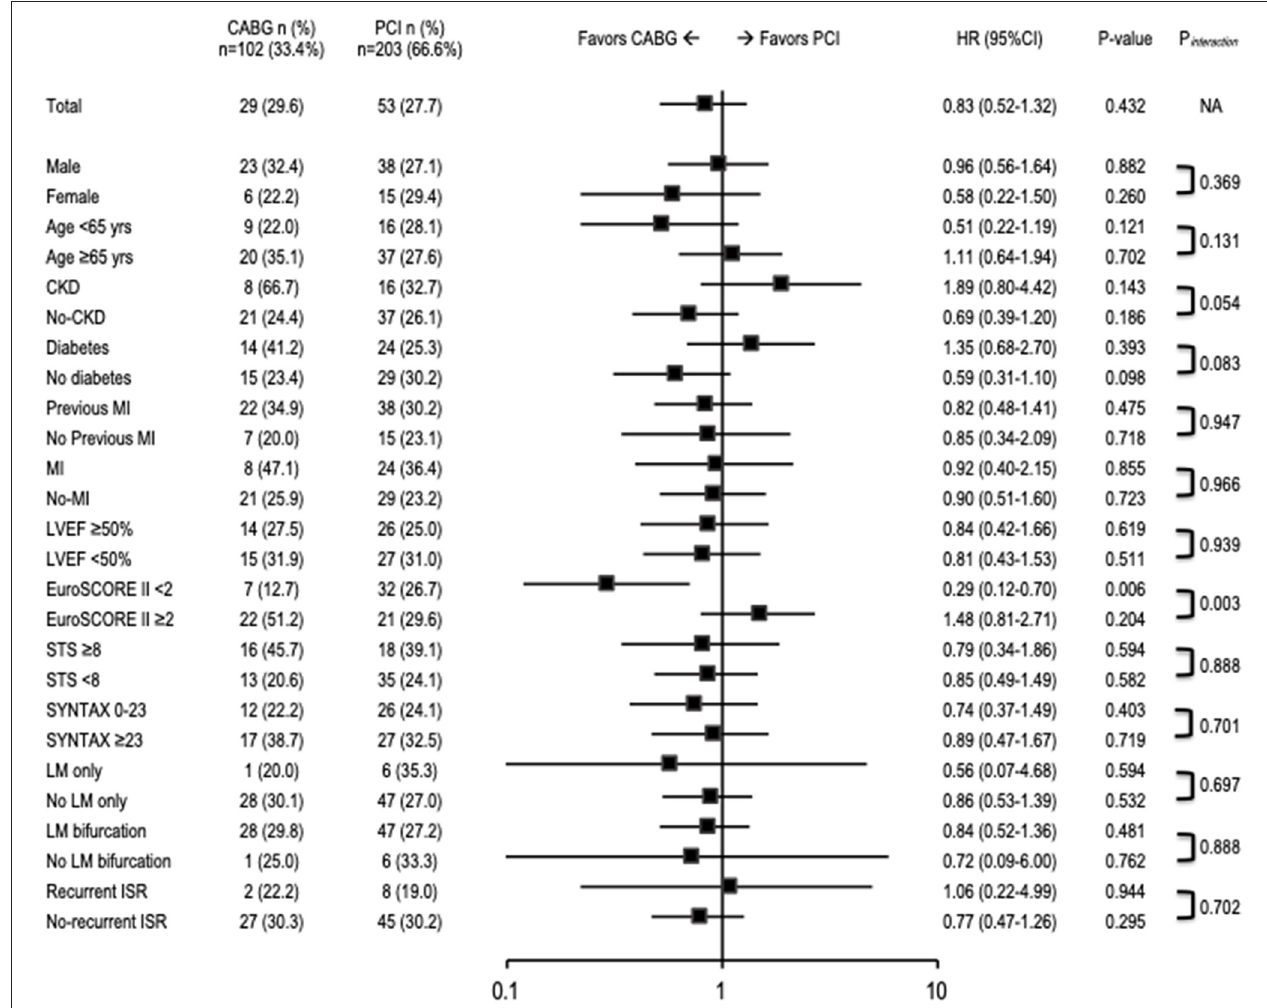
FIGURE 3 | Risk of MACCE at long-term follow-up. CABG, coronary artery bypass grafting; CI, confidence interval; CKD, chronic kidney disease; HR, hazard ratio; ISR, in-stent restenosis; LM, left main coronary artery; LVEF, left ventricular ejection fraction; MI, myocardial infarction; PCI, percutaneous coronary intervention; STS, Society of Thoracic